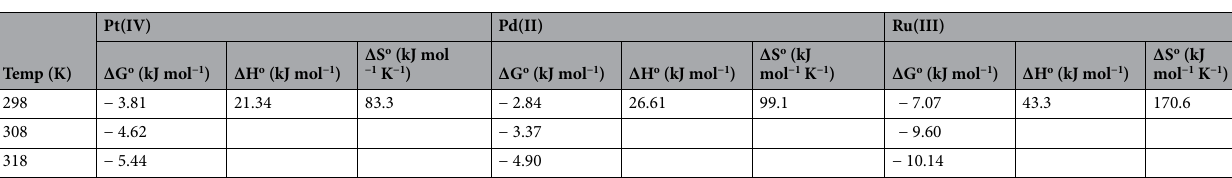
Table 5. Thermodynamic parameters for the adsorption of Pt (IV), Pd (II) and Ru(III) onto Ch-DB18C6 material.